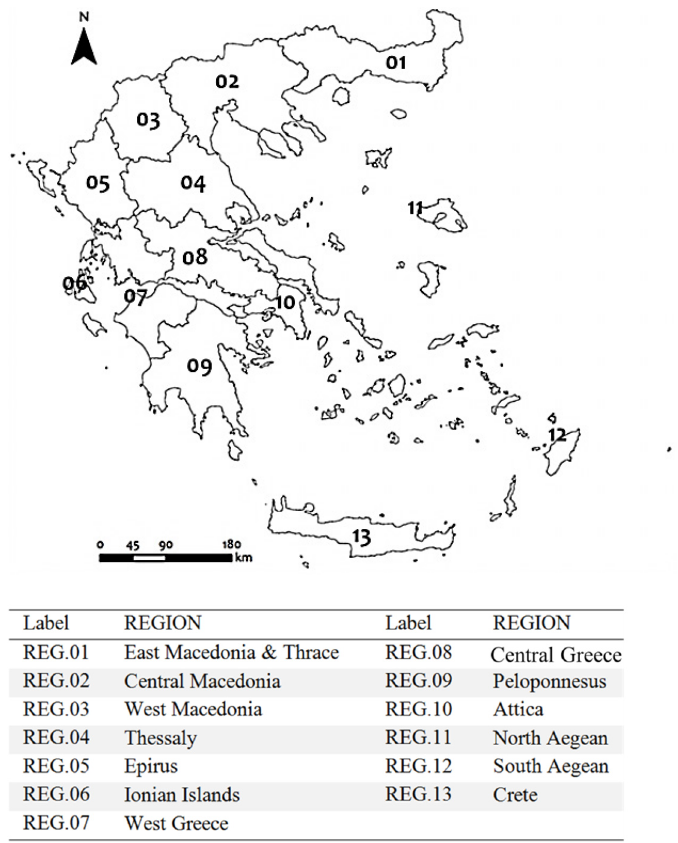
Figure 2. The Greek NUTS II regions (source: [50]).